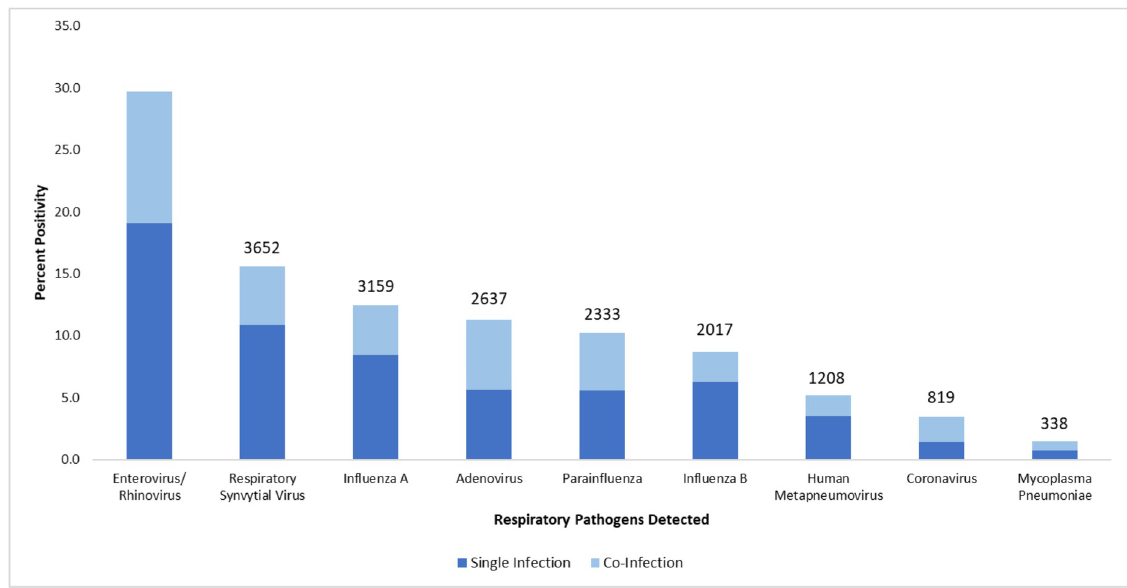
Fig 2. Percentage positivity of single and co-infections detected in each respiratory